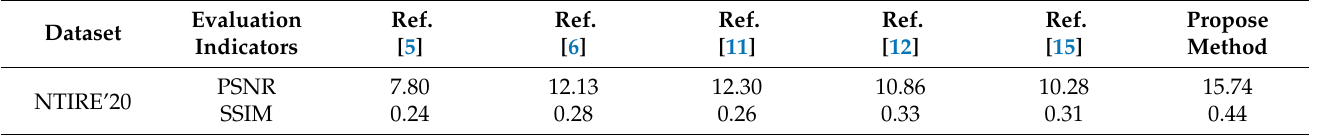
Table 2. The quantitative evaluation of different defogging methods on the NTIRE2020-Dhaze dataset. Dataset